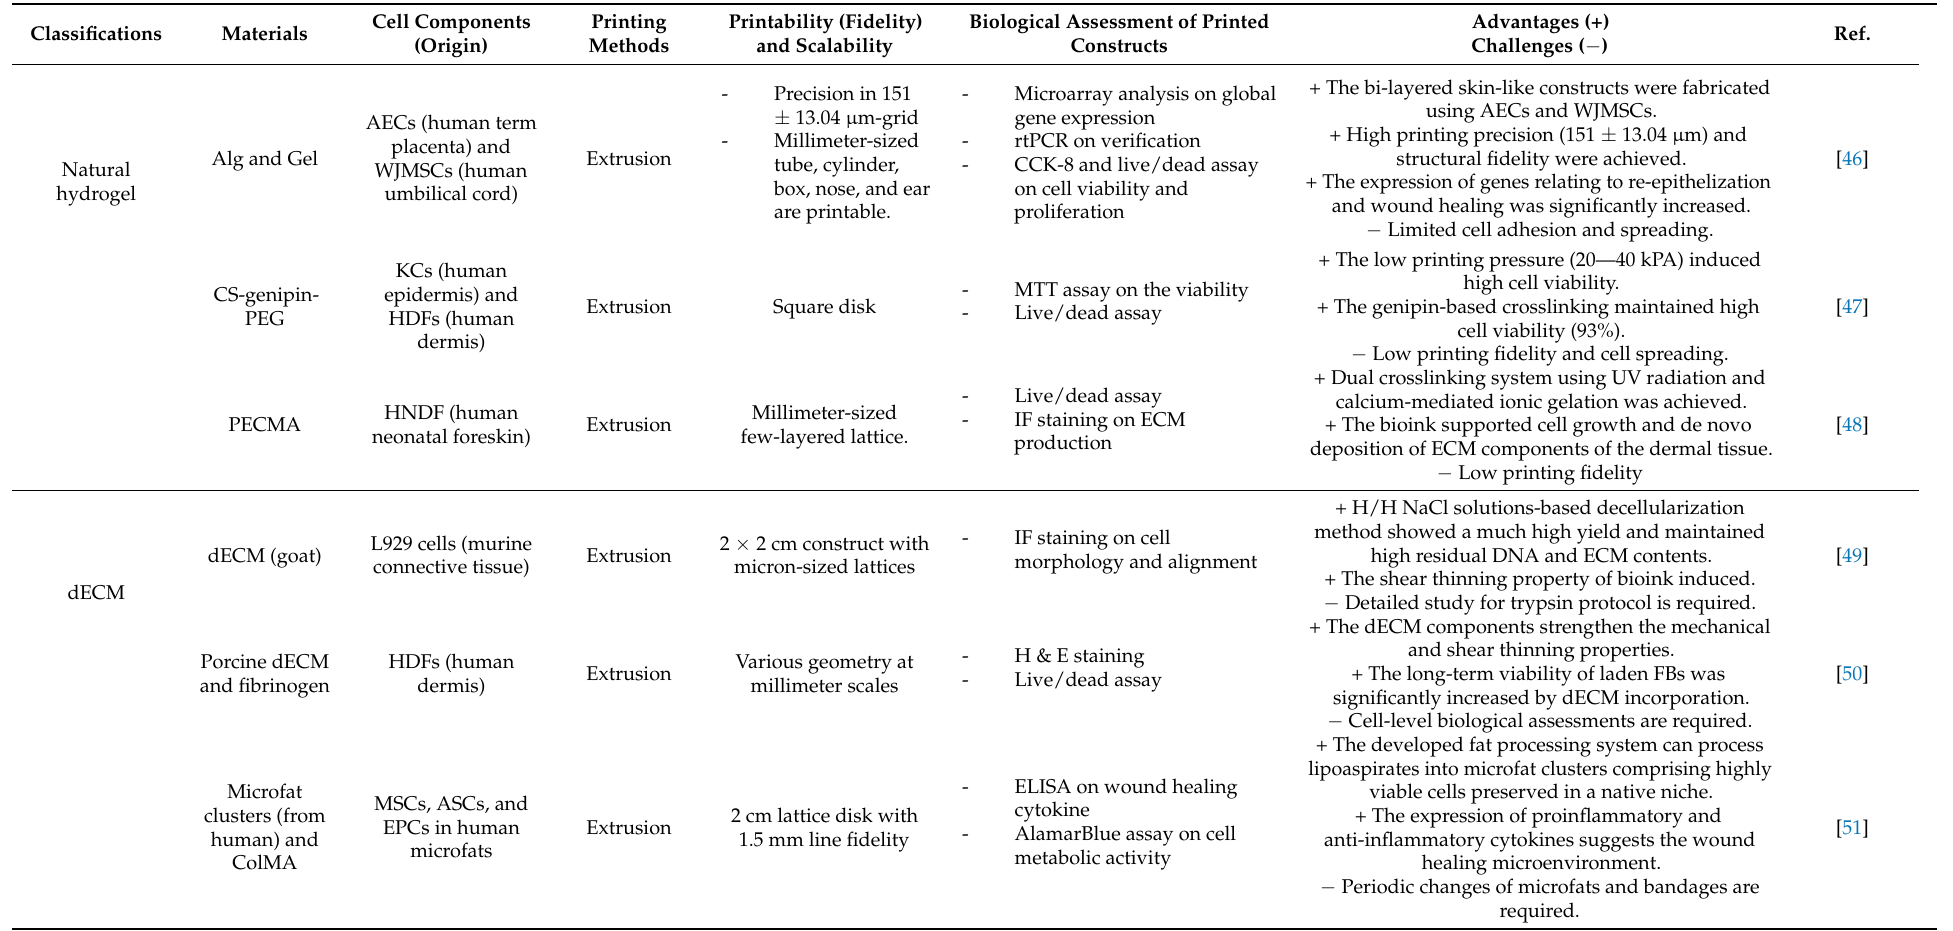
Table 1. Material advances in 3D bioprinting of